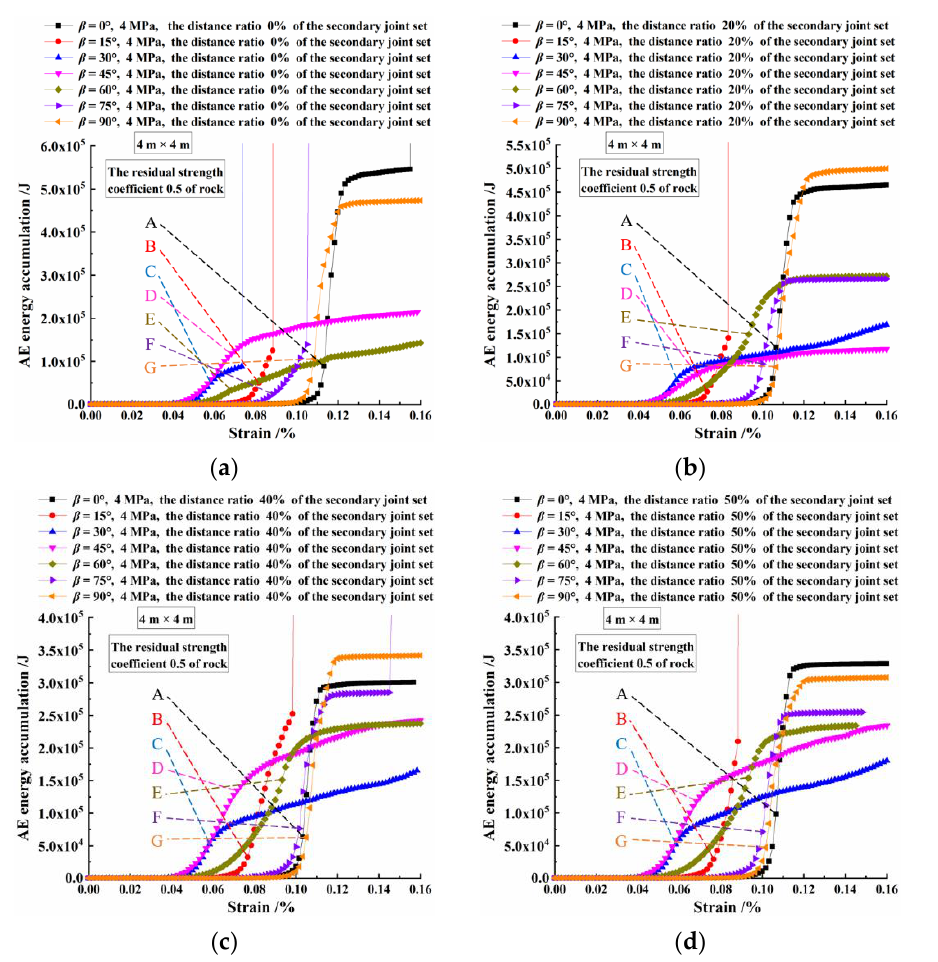
Figure 18. The AE energy accumulations for the peak stresses of the CJBs with different joint distance ratios: ( a – d ) for the joint distance ratios 0%, 20%, 40% and 50%.